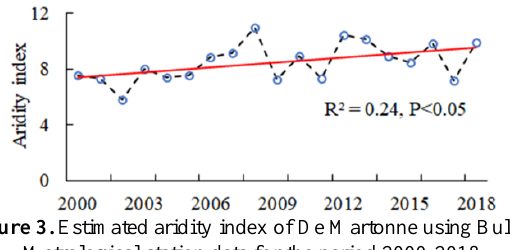
Figure 3. Estimated aridity index of De Martonne using Bulgan Metrological station data for the period 2000-2018.